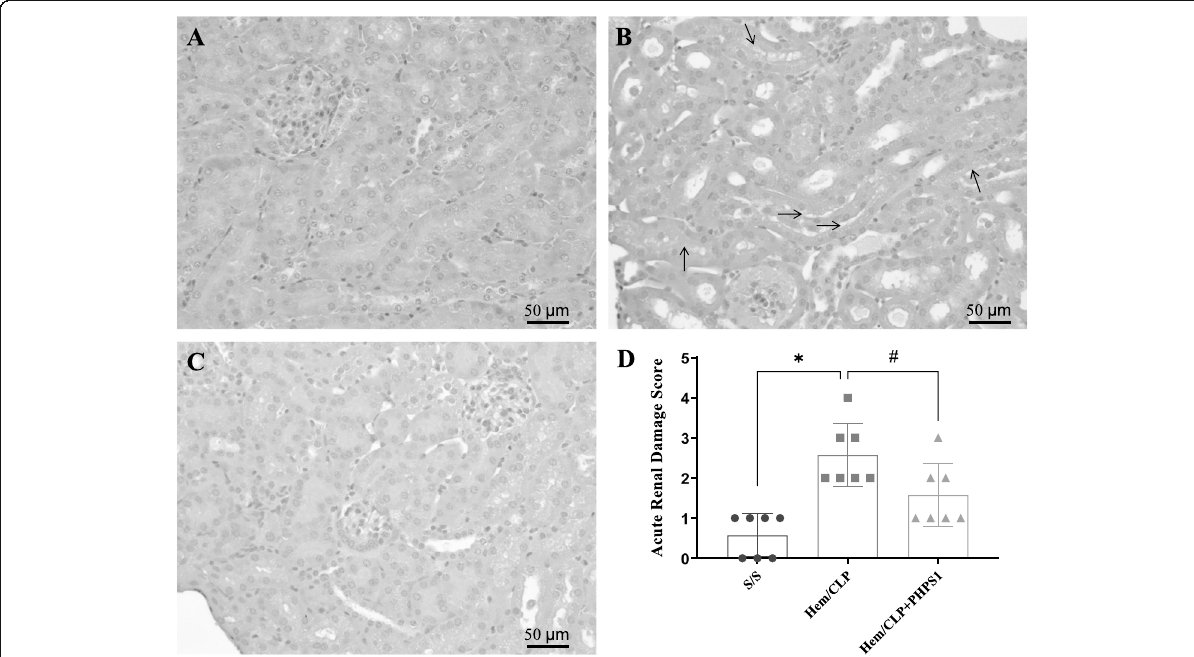
Fig. 4 Effects of SHP2 inhibition on kidney histopathologic changes after Hem/CLP. The kidneys were collected 24 h post Hem/CLP or Sham operation. Representative H&E staining of kidney sections for detection of injury by pathological changes. Compared to S/S group ( a ), the kidney from Hem/CLP mice ( b ) exhibited tubular epithelial cell sloughing/detachment (black arrows), edema, inflammatory cell infiltration, loss of brush borders, tubular dilation, and tubular distortion, examined under light microscopy (20X) (scale bar: 50 μ m). However, PHPS1 treatment markedly ameliorated these changes and preserved the renal architecture ( c ). The summary data of injury score of 3 – 5 fields/slide/sample at 200x magnification ( d ). *, P < 0.05, versus Sham (S/S); #, P < 0.05, PHPS1 treated group (Hem/CLP + PHPS1) versus Hem/CLP + vehicle (Hem/CLP). One- way ANOVA and a Student-Newman-Keuls ’ test, Mean ± SD; n = 6